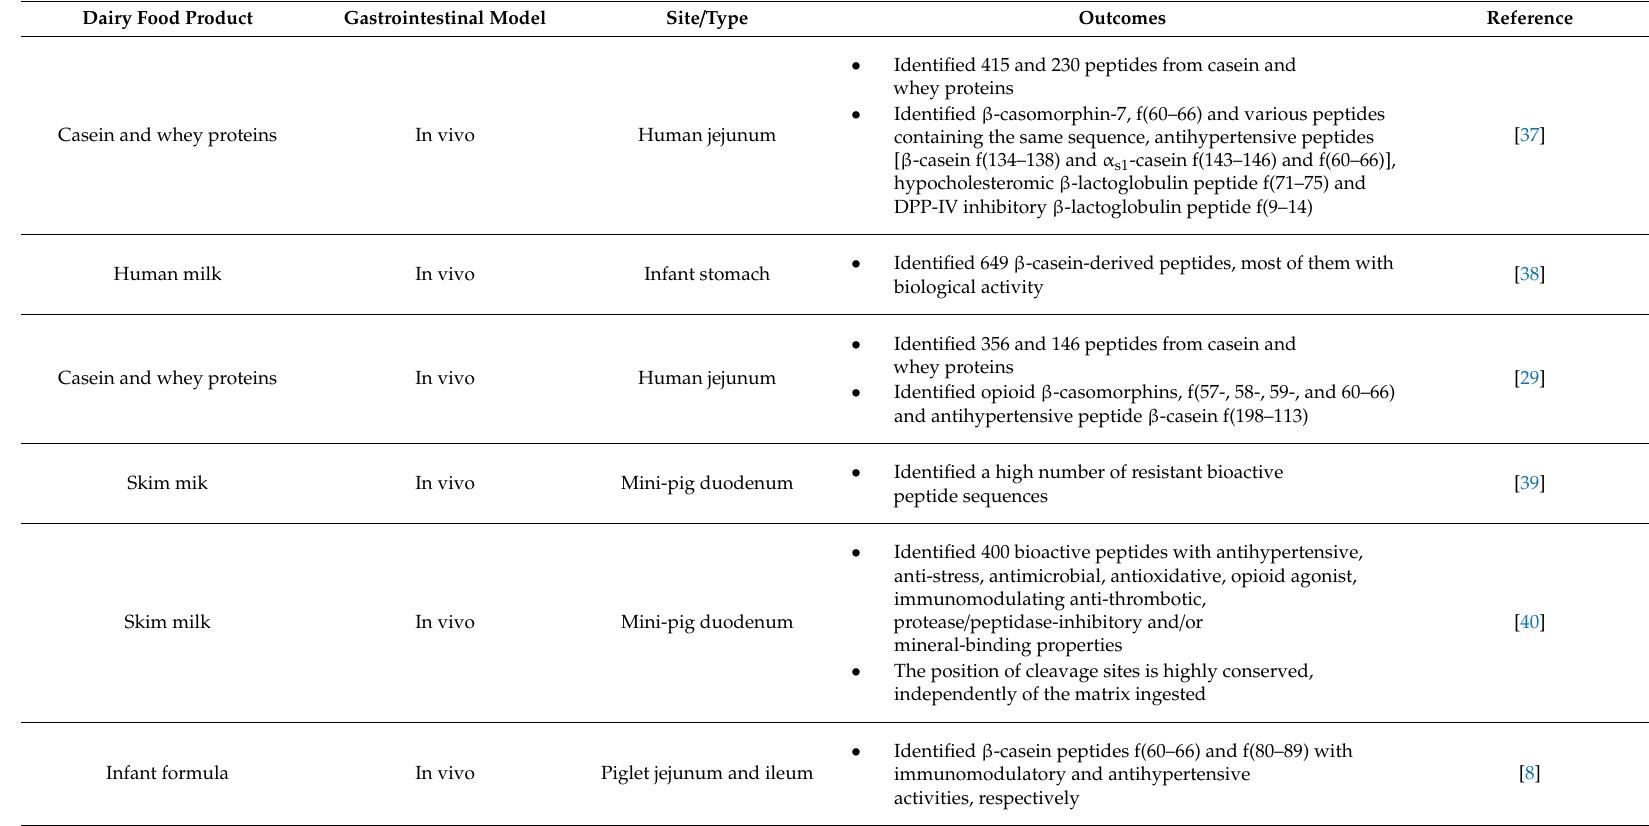
Table 1. Some examples of recent studies on gastrointestinal models used to evaluate the digestion of bioactive peptides derived from milk